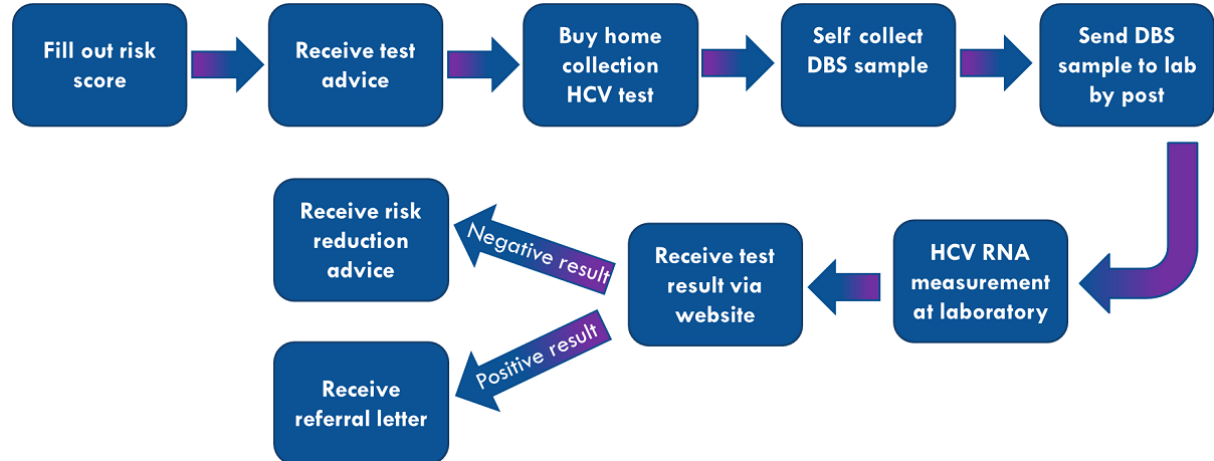
Figure 5. Flow chart of the hepatitis C testing service. DBS: dried blood spot; HCV: hepatitis C virus.